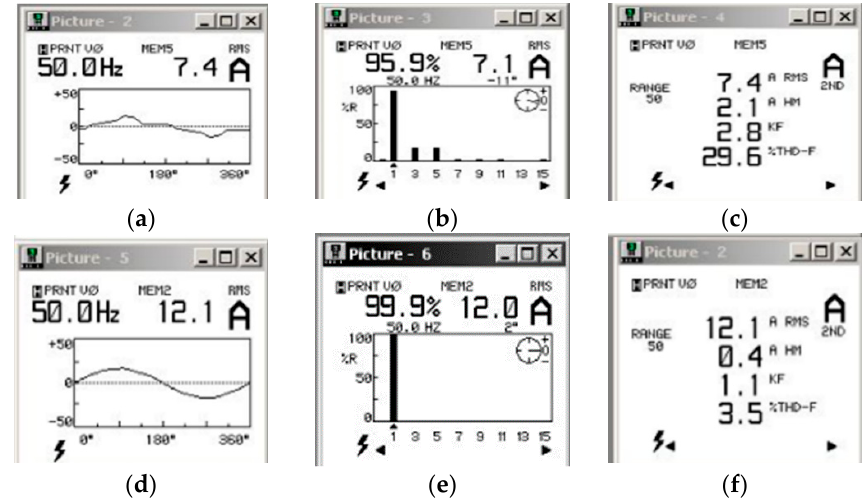
Figure 18. Waveform, harmonic spectrum and THD of the current on phase B: downstream of the PCC ( a – c ); upstream of the PCC ( d – f ).